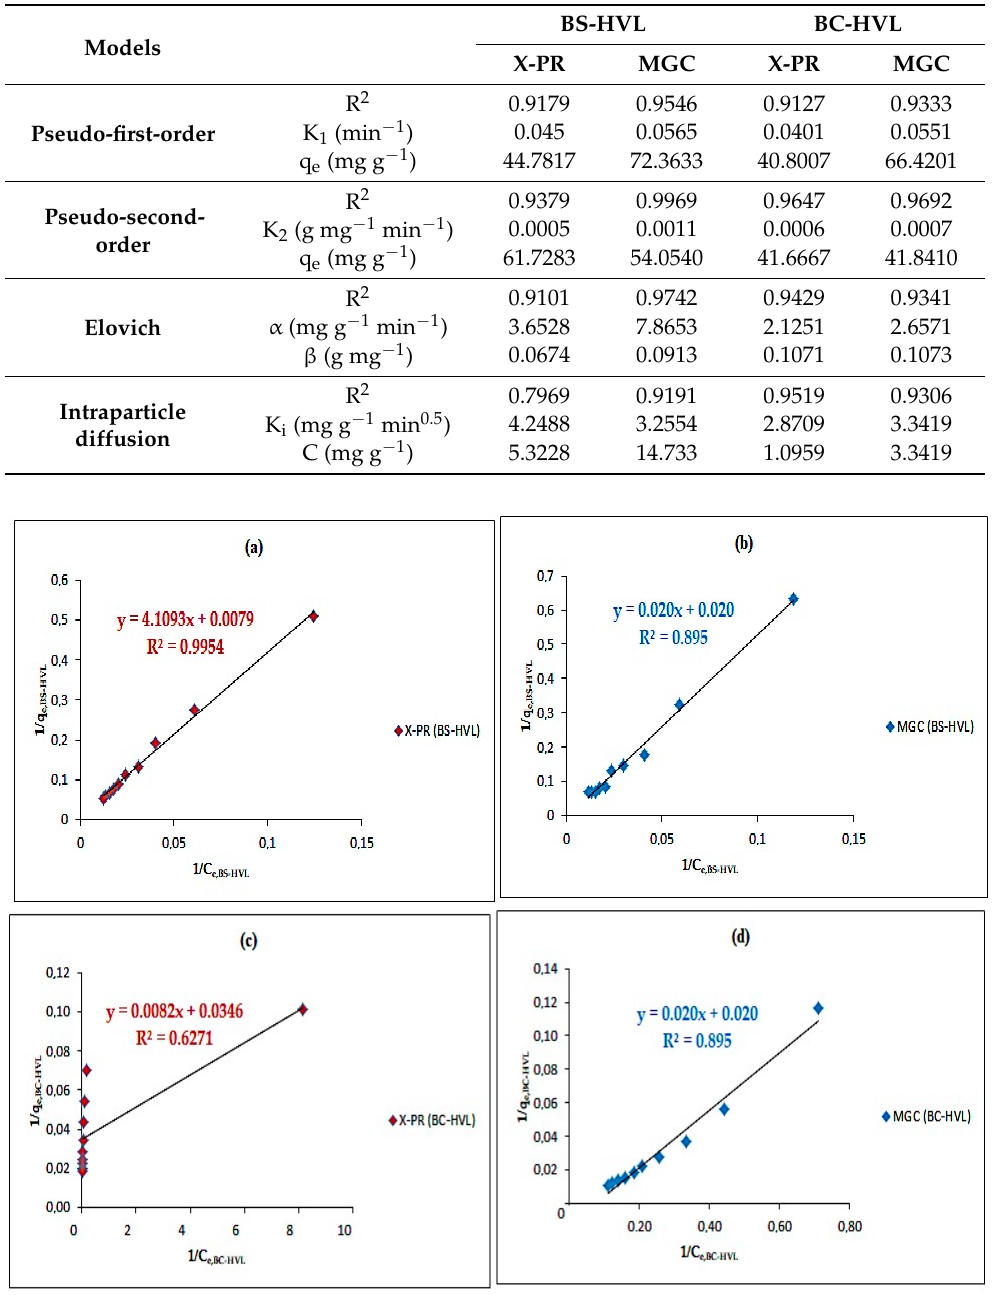
Figure 17. Langmuir isotherms for the adsorption of ( a ) X-PR and ( b ) MGC by BS-HVL (t = 90 min; T = 21 ± 1 °C; mad = 50 mg; stirring speed 150 rpm and pH = 7 ± 0.3). Langmuir isotherms for the adsorption of ( c ) X-PR and ( d ) MGC by BC-HVL (t = 90 min; T = 21 ± 1 °C; mad = 50 mg; stirring speed 150 rpm and pH = 7 ± 0.3). Table 2. Adsorption isotherms constants of X-PR and MGC on BS-HVL and BC-HVL (T = 21 ± 1